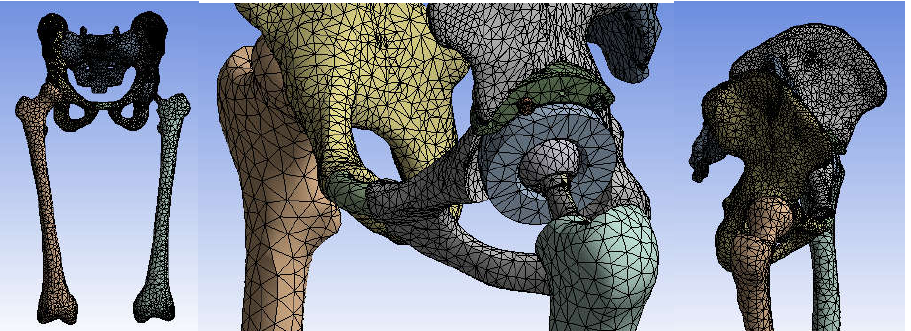
Figure 40. Finite element structure of the analysed orthopaedical system. bones and a force variation between 800 and 2300 N, placed on the sacrum bone.